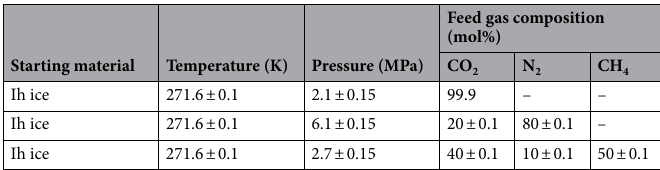
Table 1. Initial conditions of in situ Raman measurements.